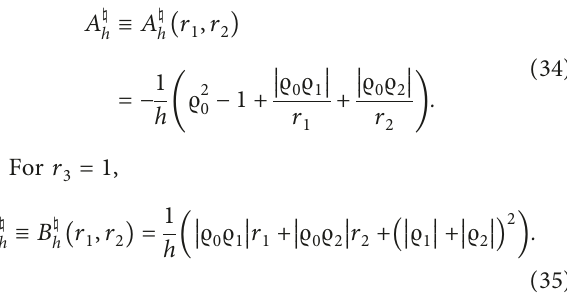
θ =0.4, λ Figure 3: Numerical simulations of model (36) with ϑ � 0 . 4 and different values of λ � 0 . 7 (a) and λ � 0 . 9